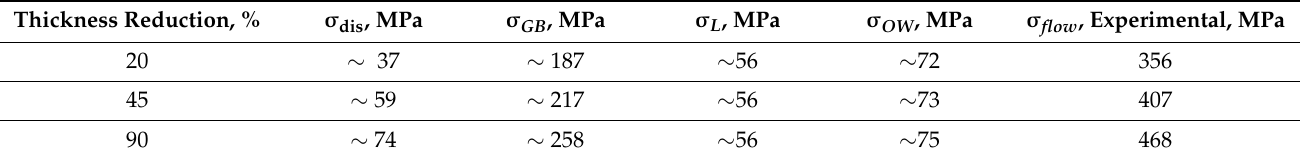
Table 3. The contribution of different strengthening